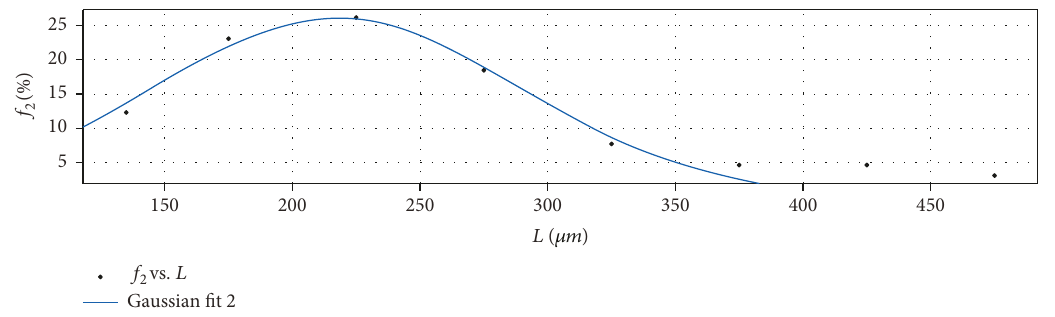
Figure 10: Data fi tting result of fi ber length distribution.